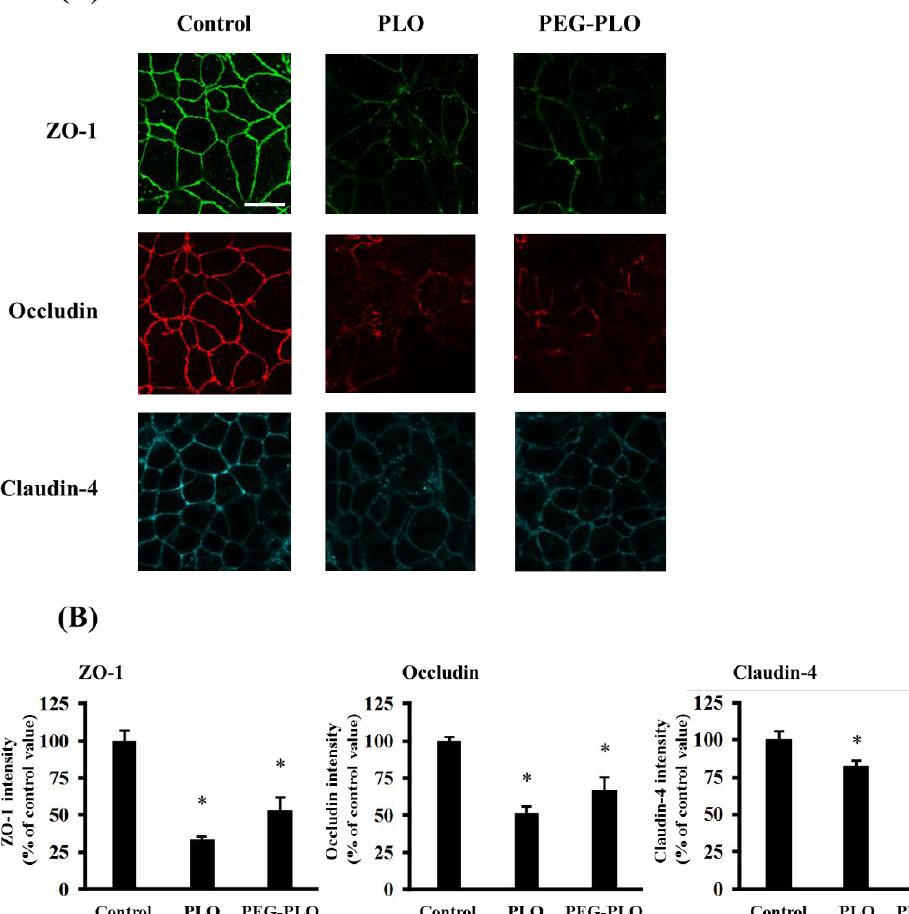
Figure 7. Effects of PLO and PEG-PLO on the distribution of tight junction (TJ) proteins in Caco-2 cells. The distribution of TJ proteins was visualized by immunofluorescent staining after exposure to PLO (1.0 µ M) and PEG-PLO (10 µ M), scale bar is 20 µ m ( A ); the intensity of each protein at the paracellular space was calculated ( B ). Each data column represents the mean ± S.E. ( n = 3), * p < 0.05 compared with the control group.